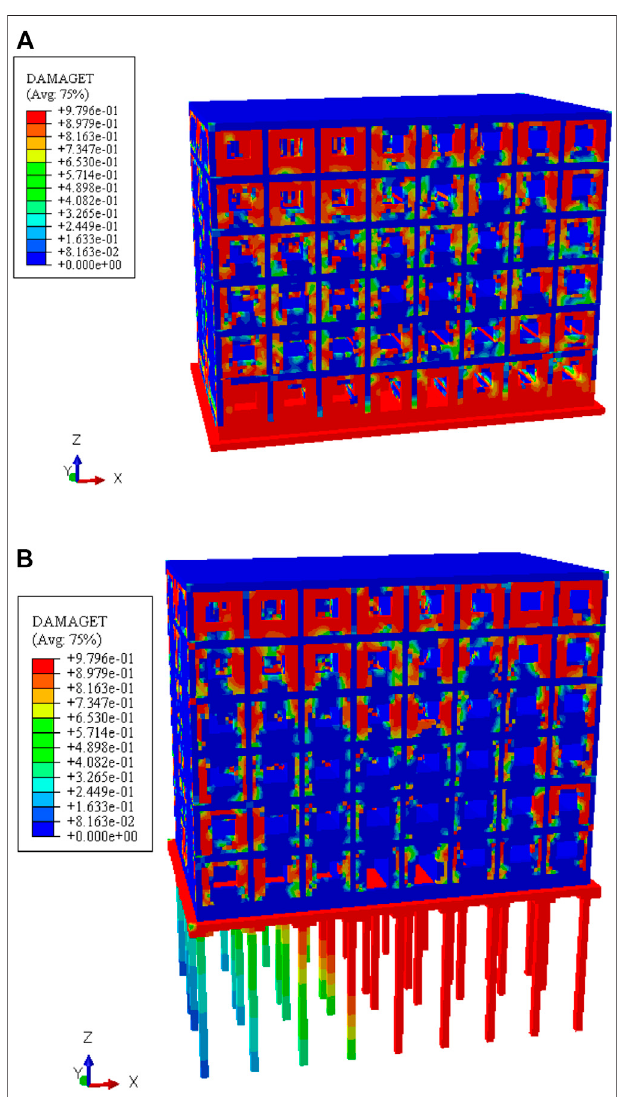
FIGURE 10 | Distribution of deformation and damage of masonry buildings with different foundation forms: (A) masonry buildings with raft foundations; (B) masonry buildings with combined pile-raft foundations.